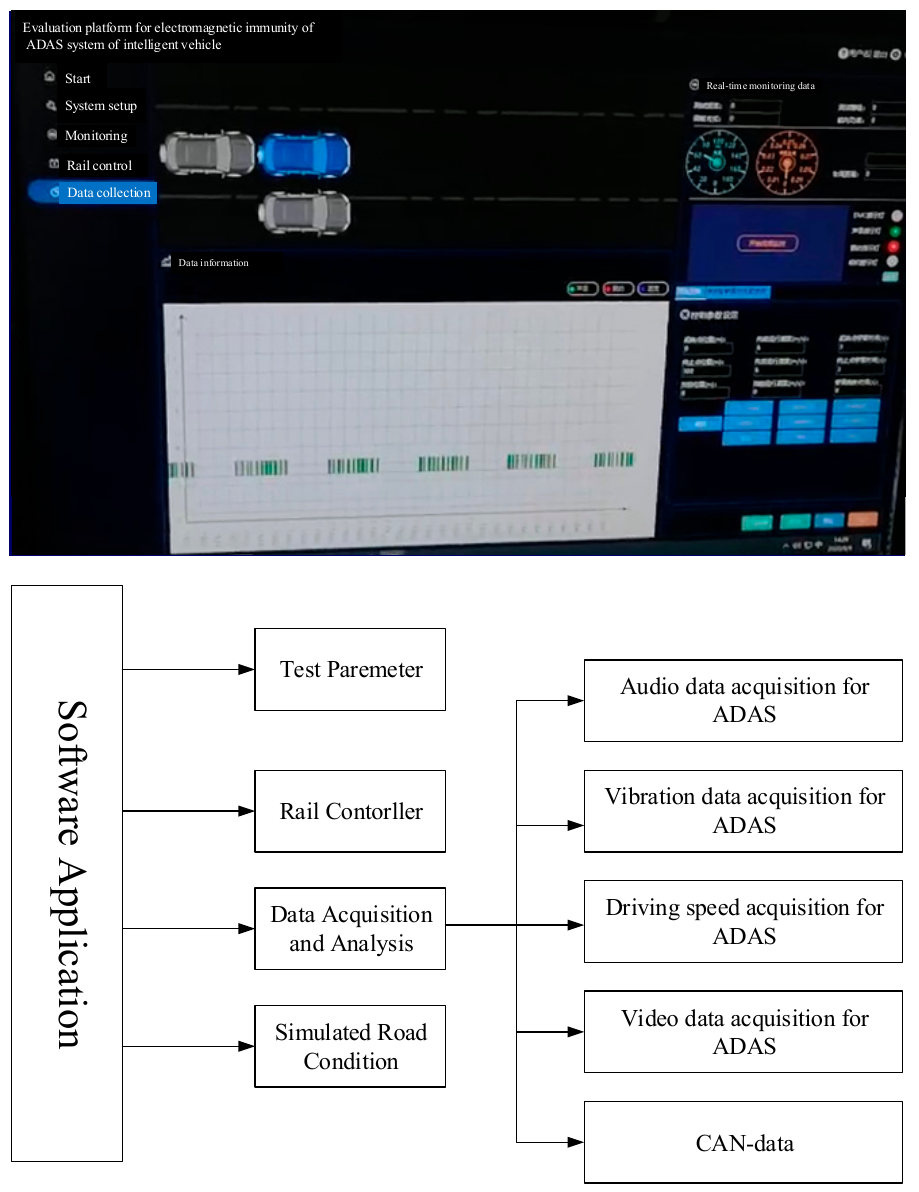
Figure 11. Test software platform and the function frame.